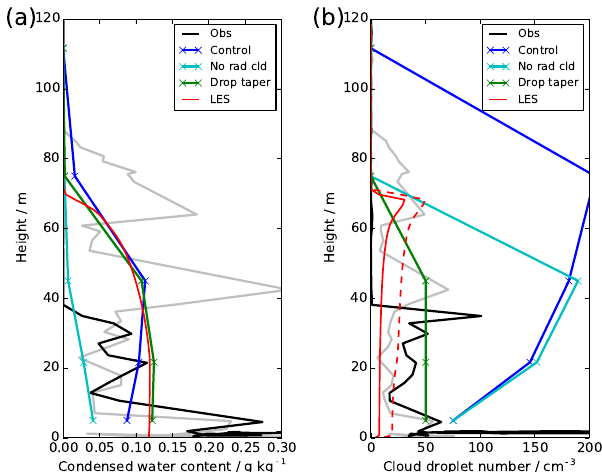
Figure 7. Time series of vertical velocity variance at screen level (2m), showing observations (black), LES (red) and UKV experi- ments: control (blue), radiatively inactive cloud (cyan) and modi- fied droplet number (green). Also shown are the Price et al. (2018) value above which fog will not form (dashed) and the minimum value used in most activation parameterisations